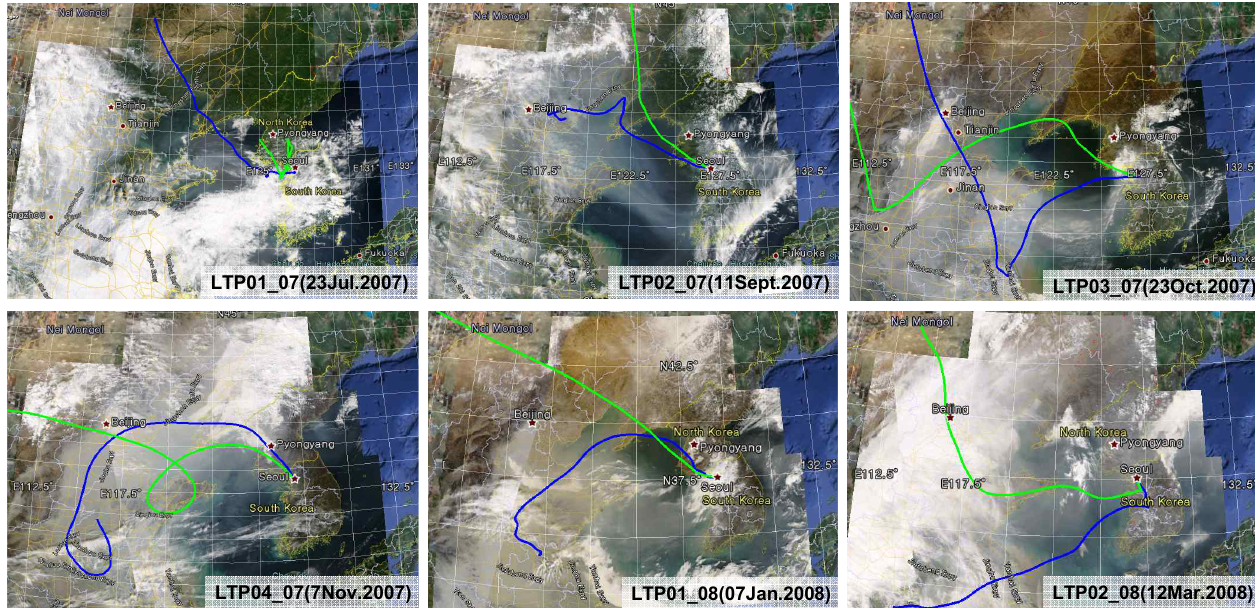
Fig. 14. MODIS RGB images and back-trajectories during the LTP periods. Blue and yellowish green are back-trajectories arriving at 500 and 1000m altitudes, respectively.